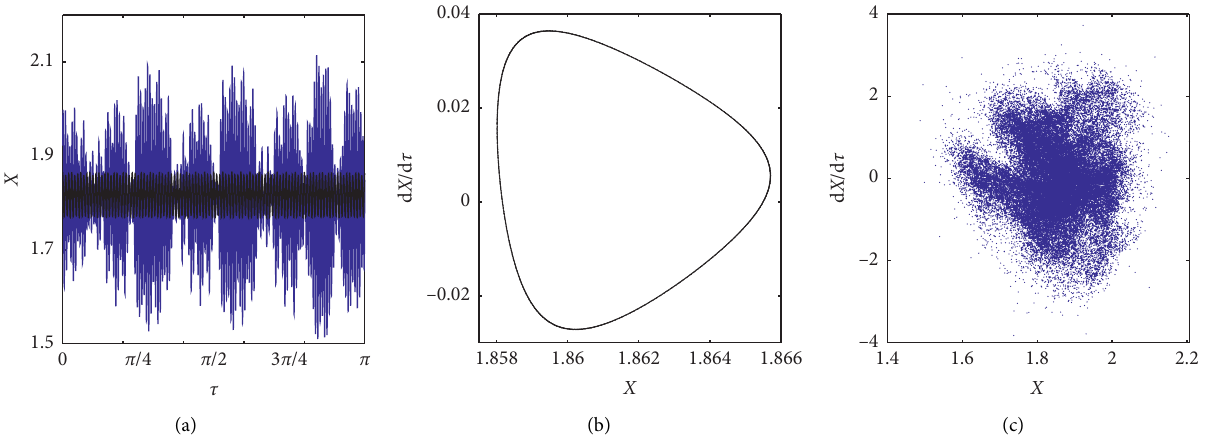
Figure 8: Time series X ( τ ) and their Poincare sections of coexisting quasiperiodic (black line or dots) and chaos (blue line dots) motions for δ 0 � 6.0 μ m and c � 200Ns/m when Ω � 174.3rad/s.